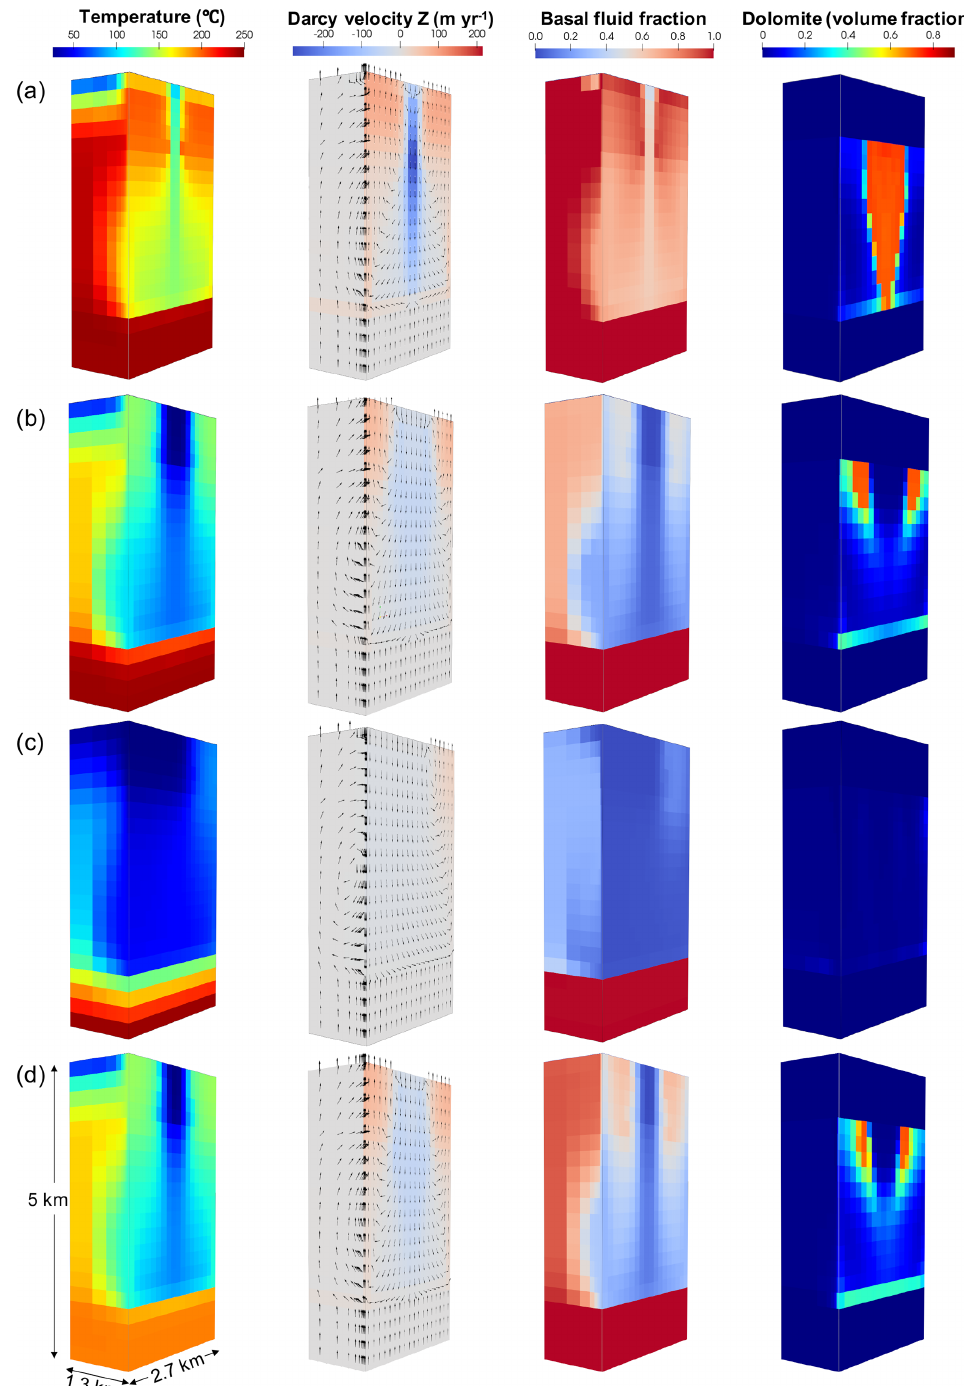
Figure 8. Simulation results at 30kyr from (a) the baseline 3D model, (b) the 50% lower permeability basement model (5 × 10 − 16 m 2 ) , (c) the 90% lower permeability basement model (10 − 16 m 2 ), and (d) the baseline model with a lower basal temperature (200 ◦ C) showing heat transfer and fluid flow (black arrows), the distribution of dolomitisation, and the basal fluid fraction. The orientation of the panels is identical to Figs. 3 and 4. Darcy velocities are positive when the flow is upward and negative when the flow is downward. The lower heat flux with either a less permeable basement or lower basal temperature (200 ◦ C) results in cooler conditions, lower fluid flux, and smaller dolomite bodies forming in zones of upwelling rather than a single large dolomite body in the zone of descending